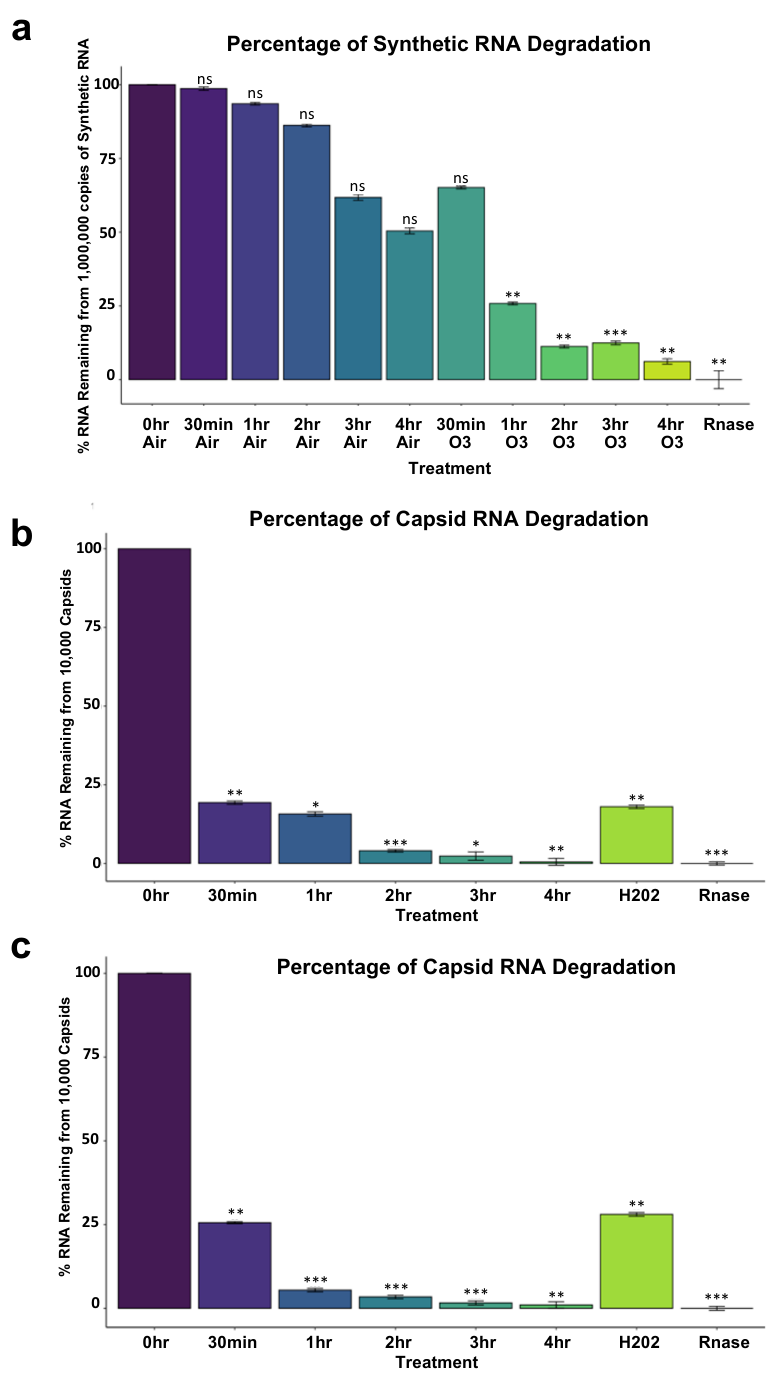
Figure 4. SARS-CoV-2 percent log fold change between ozone treatments and controls. ( a ) 10,000,000 copies of Synthetic SARS-CoV-2. ( b ) Ten thousand copies of non-replicative SARS-CoV-2. Global p < 3.2 × 10 −13 . ( c ) One thousand copies of non-replicative SARS-CoV-2. 0 h no treatment control was used as the comparison reference for ozone-treated and control samples left on the benchtop exposed to air. Rnase values indicate maximum RNA degradation. Treatment Ct values were first subtracted from 0 h control to obtain delta Ct values ( ∆ CT = CT target − CT reference). Delta Ct was then transformed into a log scale using 2 − ∆ Ct . Error bars represent variance and was calculated as s = (s12 + s22)ˆ1/2, s = standard deviation. One-way ANOVA Analysis computed global p -values, and Tukey’s method was used to distinguish p -values for multiple comparisons. Global p < 2.2 × 10 − 16 . Significance codes 0 ***, 0.001 **, 0.01